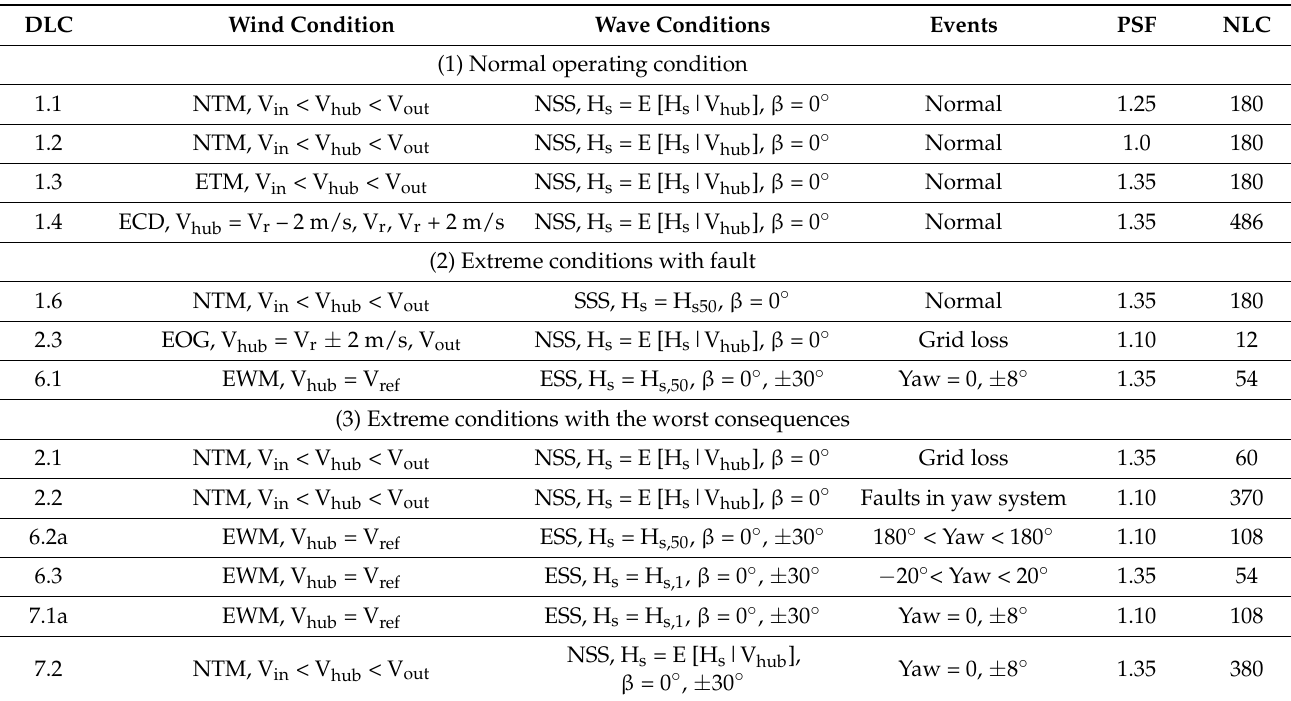
Table 2. Selected design load